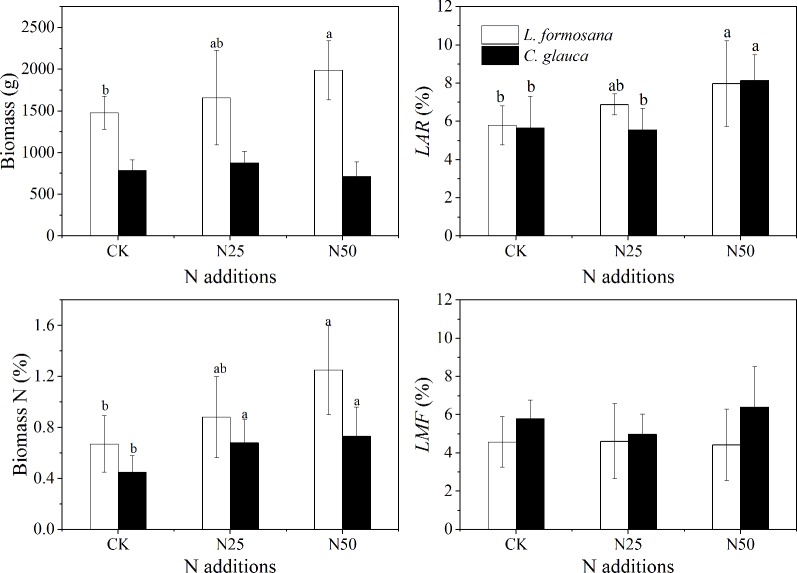
Plant biomass, the fractions of N on the biomass, leaf area divided by total aboveground biomass (LAR), and the fraction of leaf mass divided by the total aboveground biomass (LMF) of Liquidambar formosana and Cyclobalanopsis glauca under different N addition treatments: CK, N25, and N50. Plants were harvested from 15 individuals in each of the control and fertilized plots. Error bars represent 1 SD (n = 15). Different letters indicate significant differences at p < 0.05.